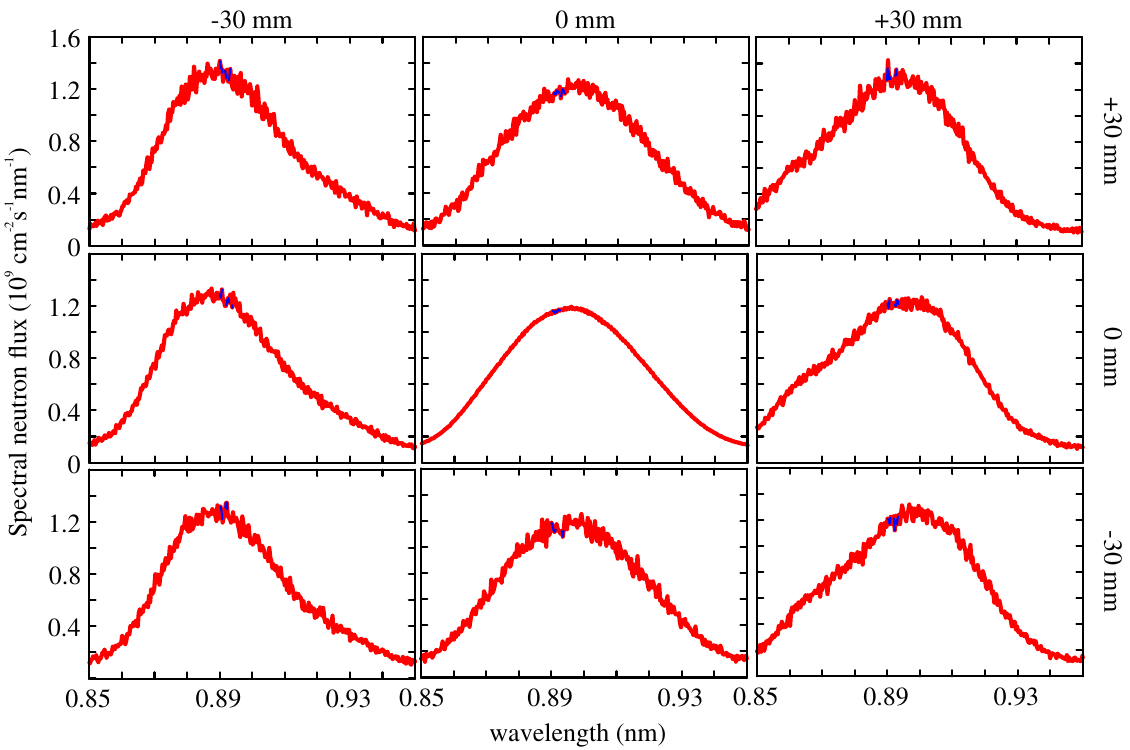
FIG. 7. Spectral neutron flux obtained by time-of-flight measurement at various positions of the beam. The positions are given relative to the center of the exit window of the GRANIT neutron guide, after the shutter. The blue lines cover the range of interest for UCN